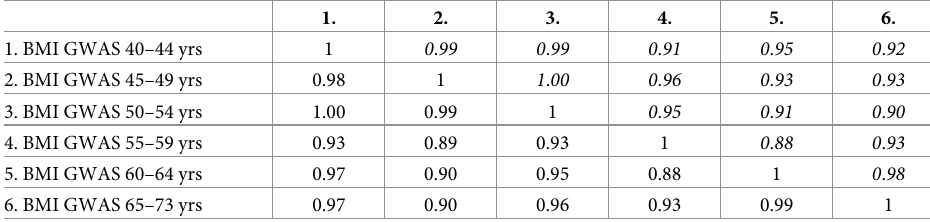
Table 3. Linkage disequilibrium score regression genetic correlations based on the male (below diagonal) & female (above diagonal italics) GWAS summary statistics at six age intervals. 1. 2. 3. 4. 5. 6.